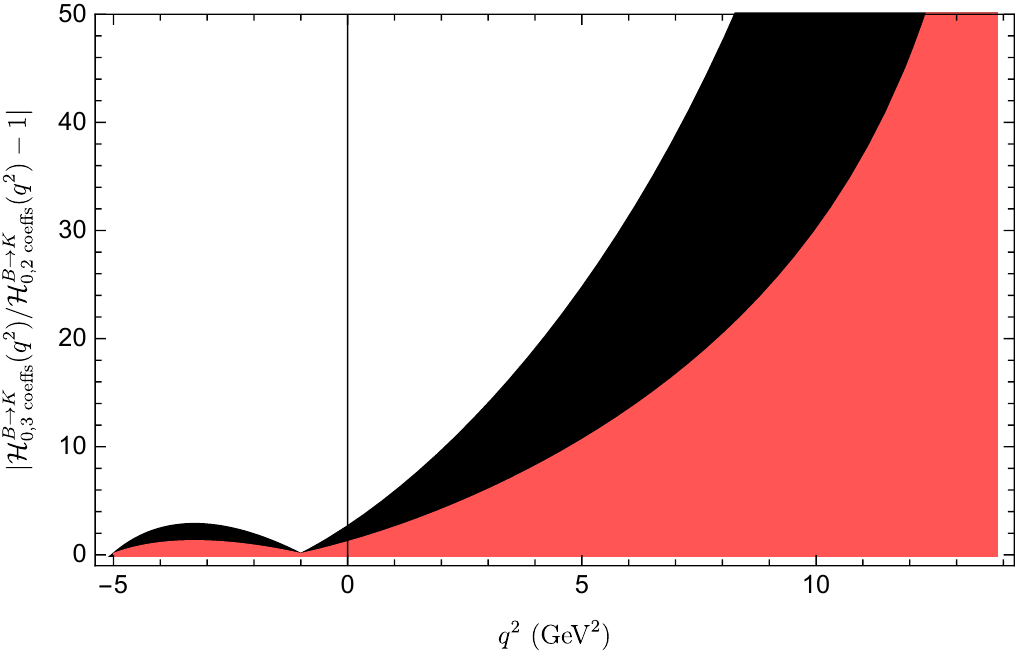
with two Figure 2 . Estimate of the (relative) truncation error in the determination of H B → K 0 coefficients and two theory constraints at q 2 = − 1 GeV and − 5 GeV . The black region disregards the contribution from other modes (most conservative situation), while the red region assumes equal contributions from all ¯ B → ¯ K ( ∗ ) ‘ + ‘ − and ¯ B + ‘ − modes (cf. figure s → φ‘